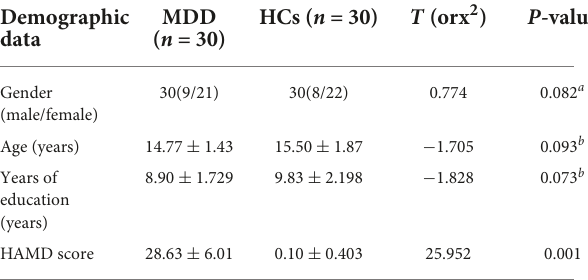
TABLE 1 Demographics and clinical characters of healthy controls (HCs) and MDD patients.